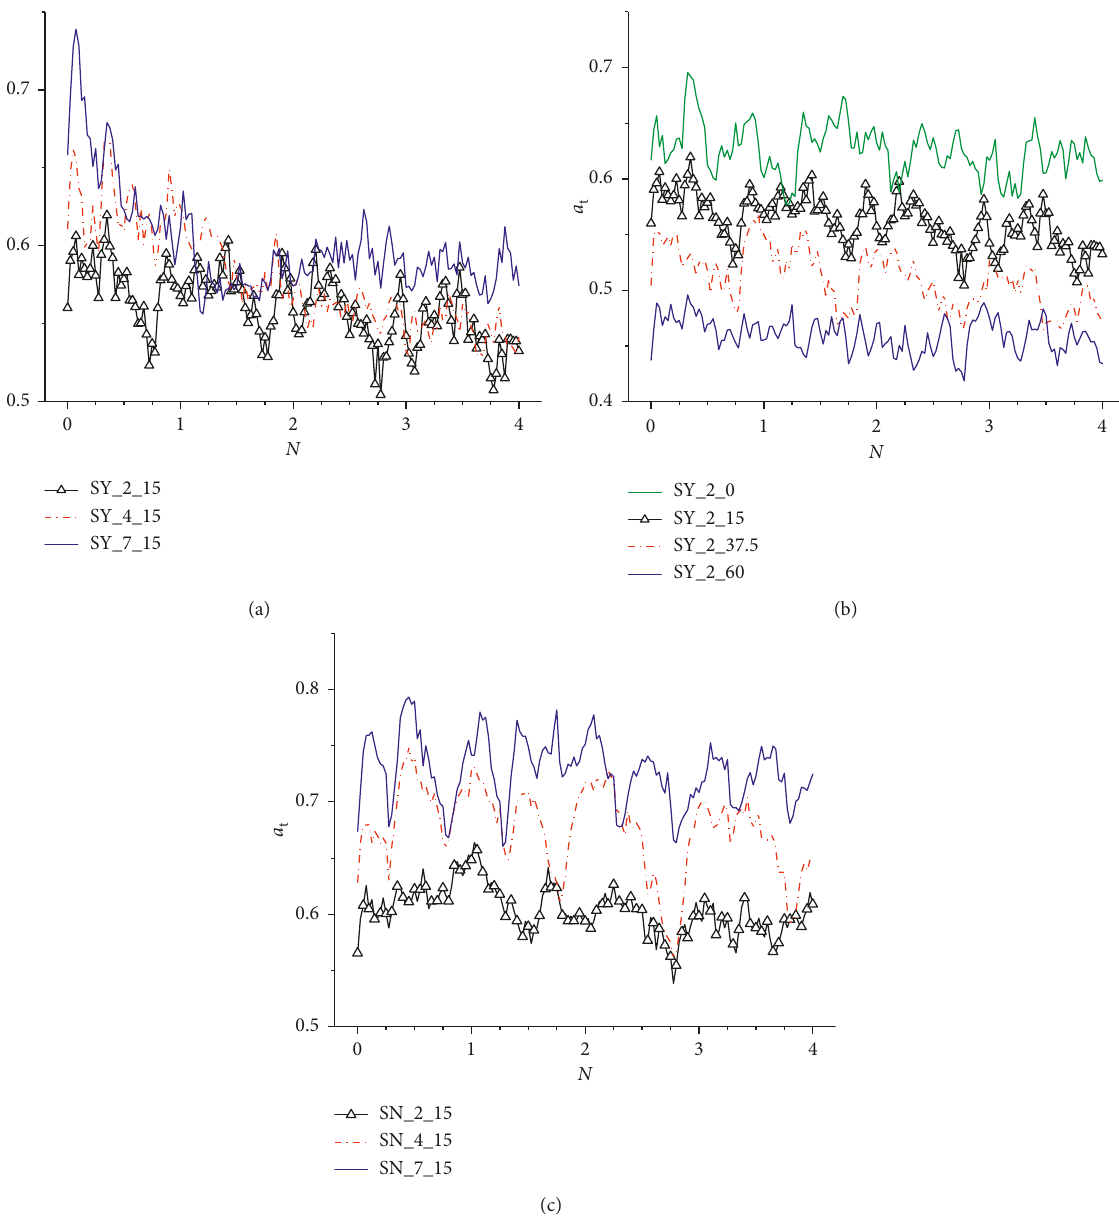
Figure 18: Evolution of a : (a) reference group; (b) composite pattern group; (c) unbreakable t